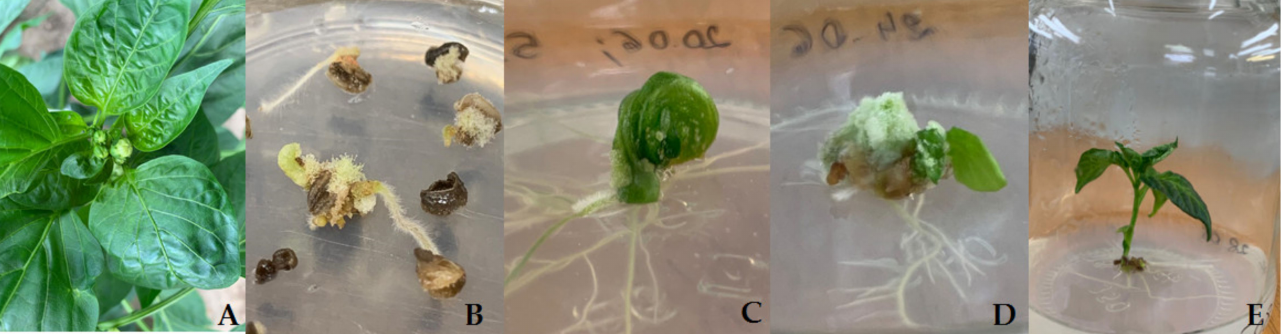
Figure 1. In vitro anther culture of peppers: ( A ) anther donor plants of ( Capsicum annuum L. ATZ × Capsicum annuum L. Corno di toro)F 2 , ( B ) embryo conversion of morphological anomalies, ( C ) de- formed cotyledons, ( D ) callogenesis on the leaves, and ( E ) androgenic regenerant. The cytometric analysis of the regenerants showed that one plant was haploid, and the other was diploid (Figure